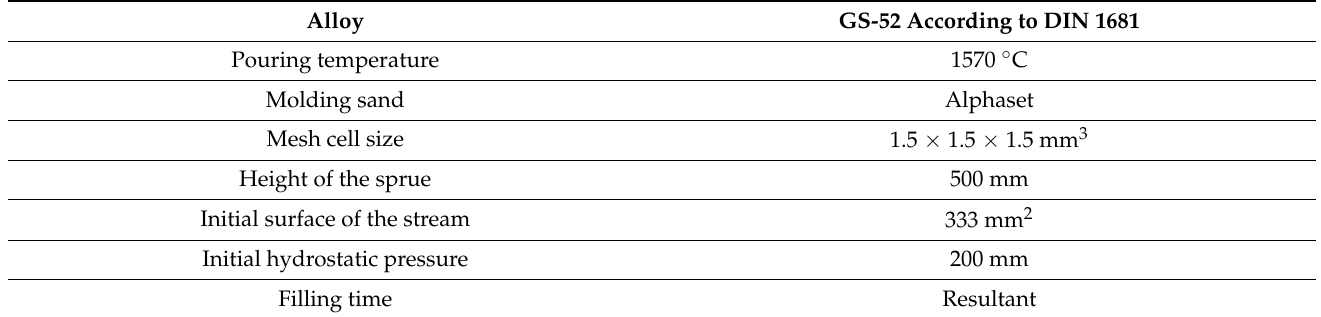
Table 2. Simulation parameters of initial studies of